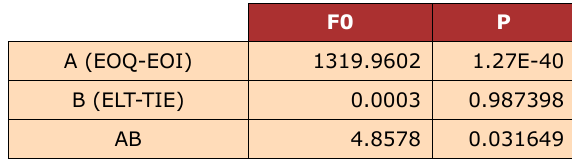
Table 4. DoE analysis – Bullwhip